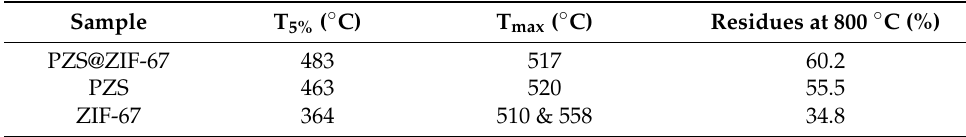
Table 1. TGA data of ZIF-67, PZS, and PZS@ZIF-67.